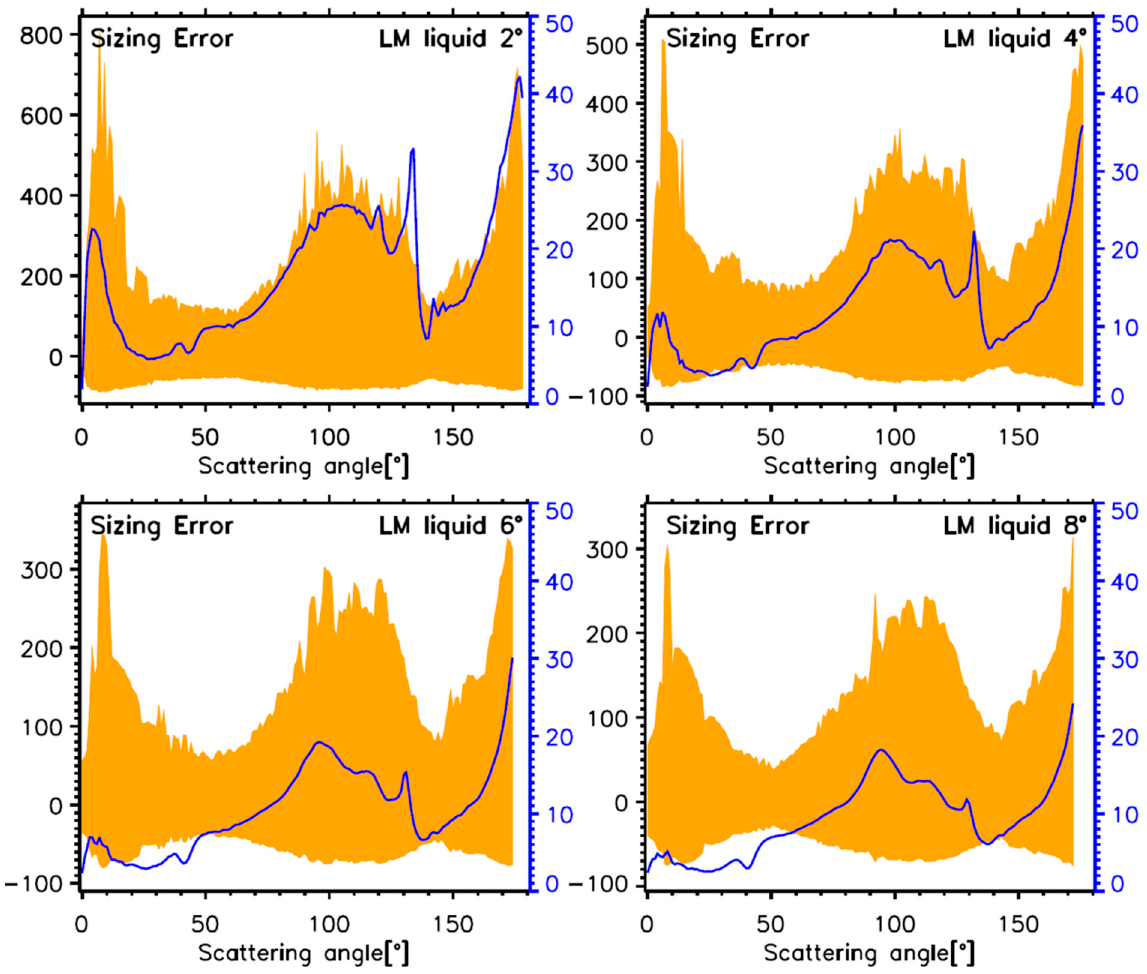
Figure 13. Determined ranges (orange shaded areas, left vertical axis) of minima and maxima and average (blue lines, right vertical axis) of sizing errors (%) for measured spherical liquid cloud droplets using a Lorenz–Mie code (LM liquid) as a function of scattering angle. Different panels indicate different resolutions (i.e., 2°, 4°, 6°, and 8°) of scattering angles.